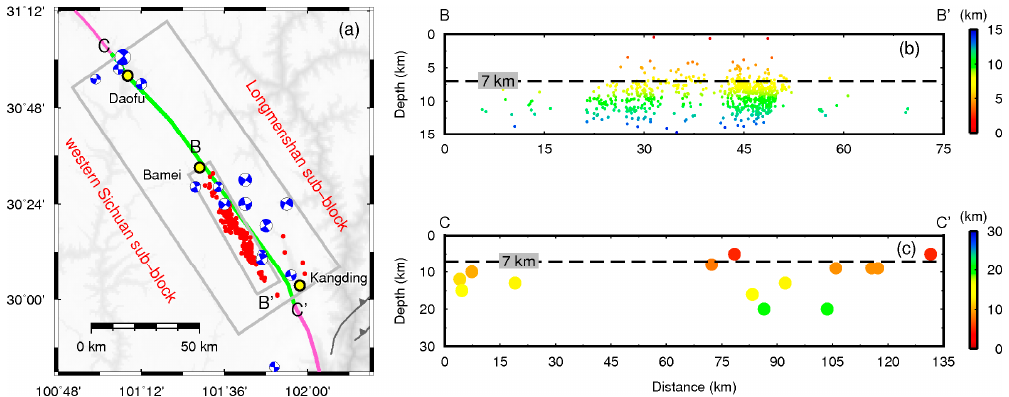
Figure 7. Seismicity along the SDK. ( a ) Red points show the aftershock distribution of the 2014 Kangding earthquake. Blue beachballs indicate the focal mechanisms of historical earthquakes ( M w ≥ 4.0) since 1970; ( b ) Relocated aftershock hypocenters of the Kangding earthquake are color coded with source depth. The dashed line indicates the estimated locking depth; ( c ) Depth profile of historical earthquakes along profile C–C’.